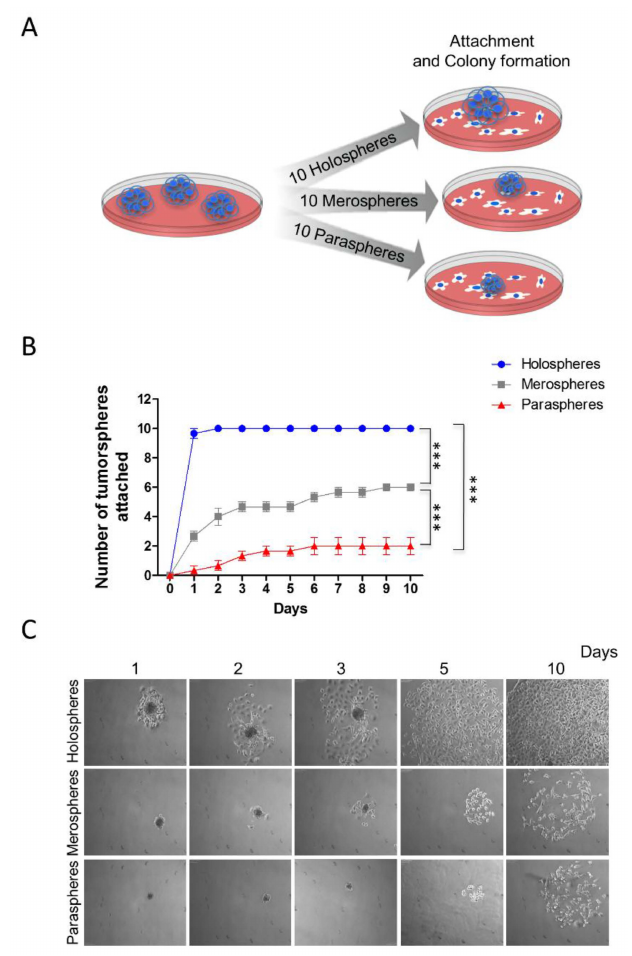
Figure 2. Increased reattachment and spreading of tumor cells from holospheres . ( A ) Schematic representation of tumor spheres ( n = 10) isolated based on morphology (holospheres, merospheres, or paraspheres) and seeded into culture dishes (adherent culture conditions); ( B ) Time course and quantification of adhesion efficiency of tumor spheres (*** p < 0.001); ( C ) Representative examples of holospheres, merospheres, and paraspheres adhering and spreading in culture